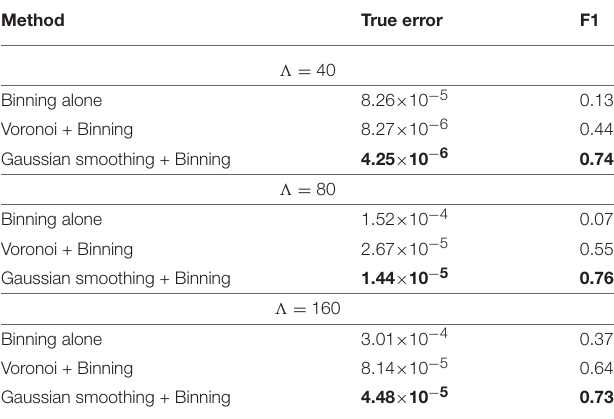
TABLE 2 | Squared errors between the estimated marker load and the true population marker load as well as cluster detection F1 scores are shown for each simulation experiment and for each marker load estimation